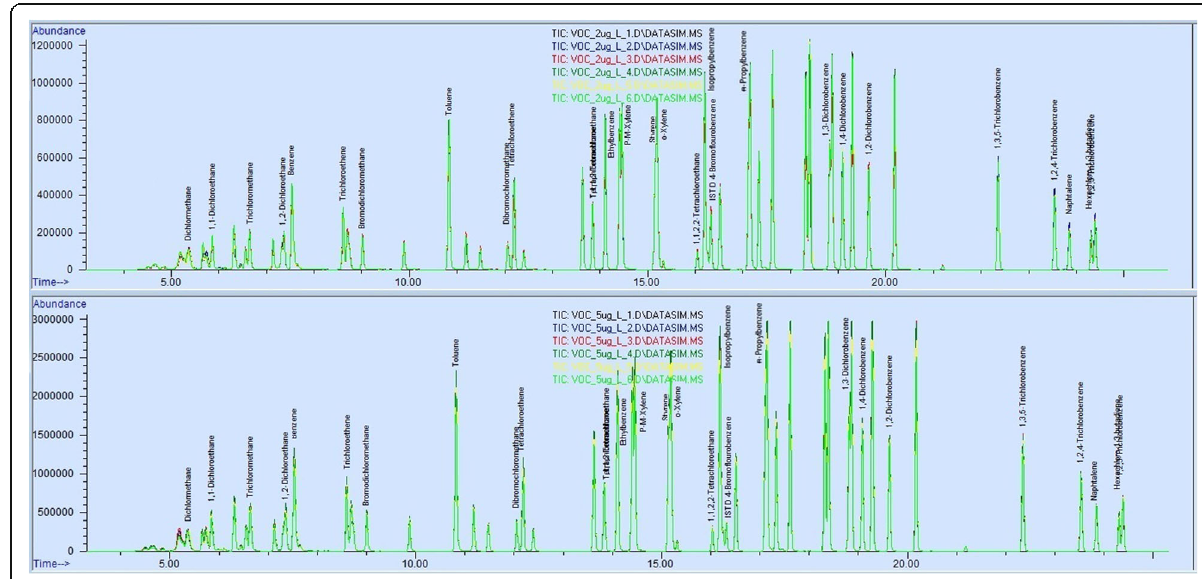
Fig. 4 Overlaid chromatograms of precision study at 2 μ g/L and 5 μ g/L standard